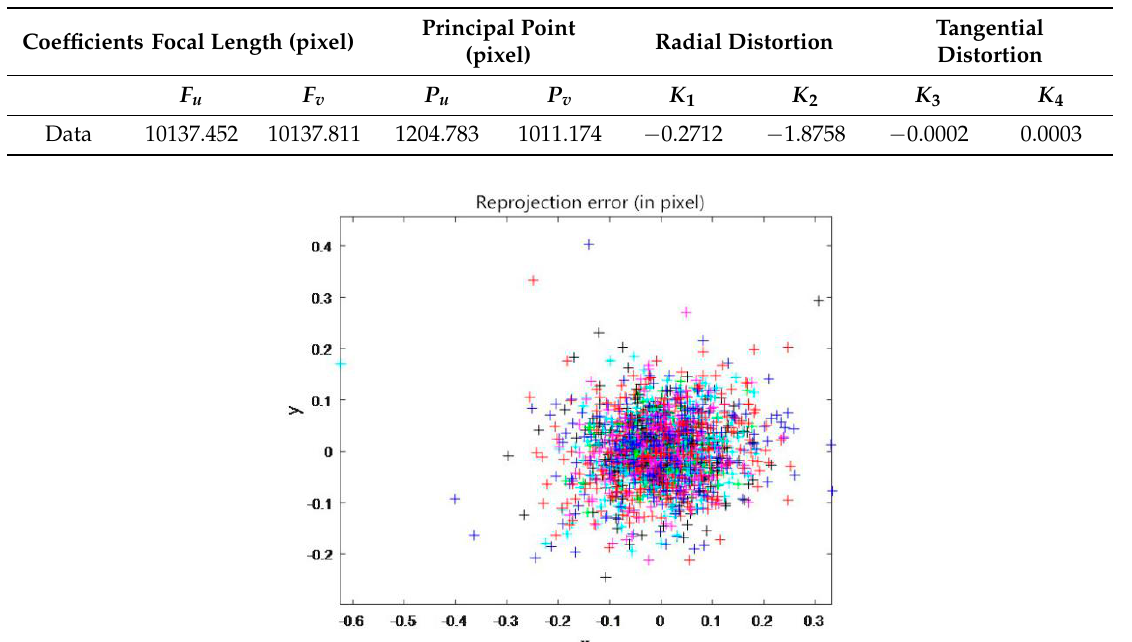
Table 1. The calibrated internal parameters of the camera.